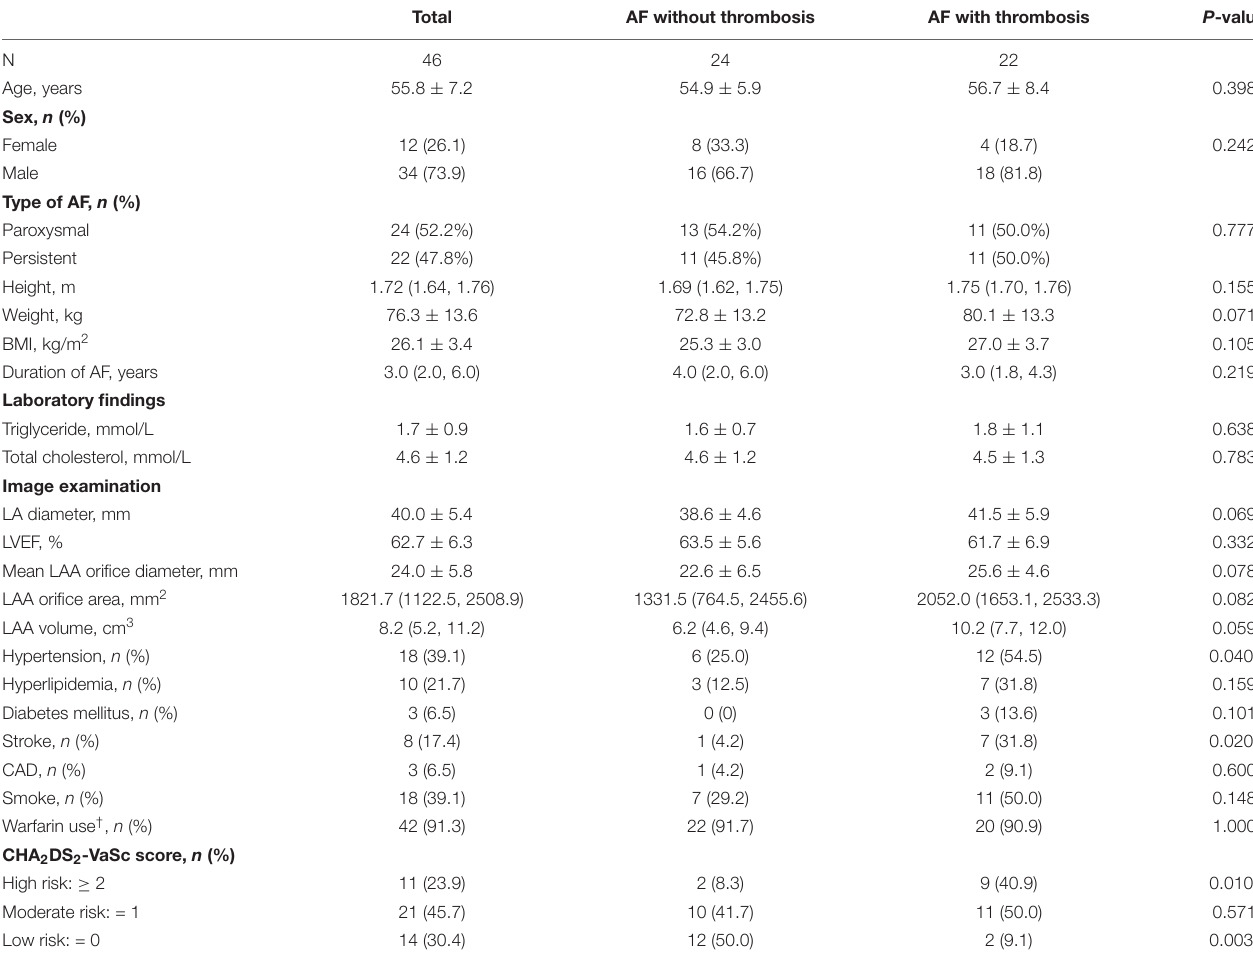
TABLE 1 | Clinical characteristics of patients with AF and with and without thrombosis. Total AF without thrombosis AF with